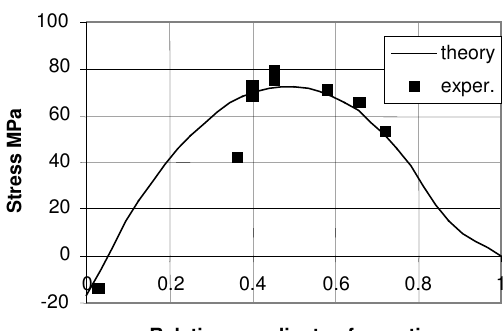
Fig 7. Comparison of predicted and measured stresses in skin of